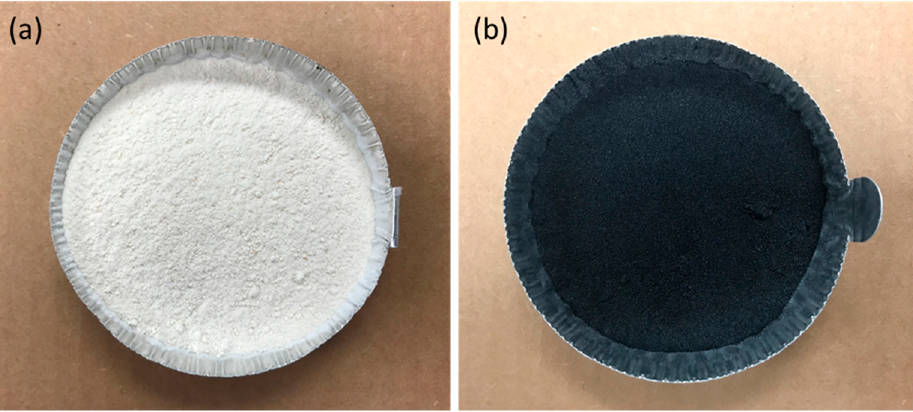
Figure 1. Images of ( a ) CMF and ( b ) MRP.